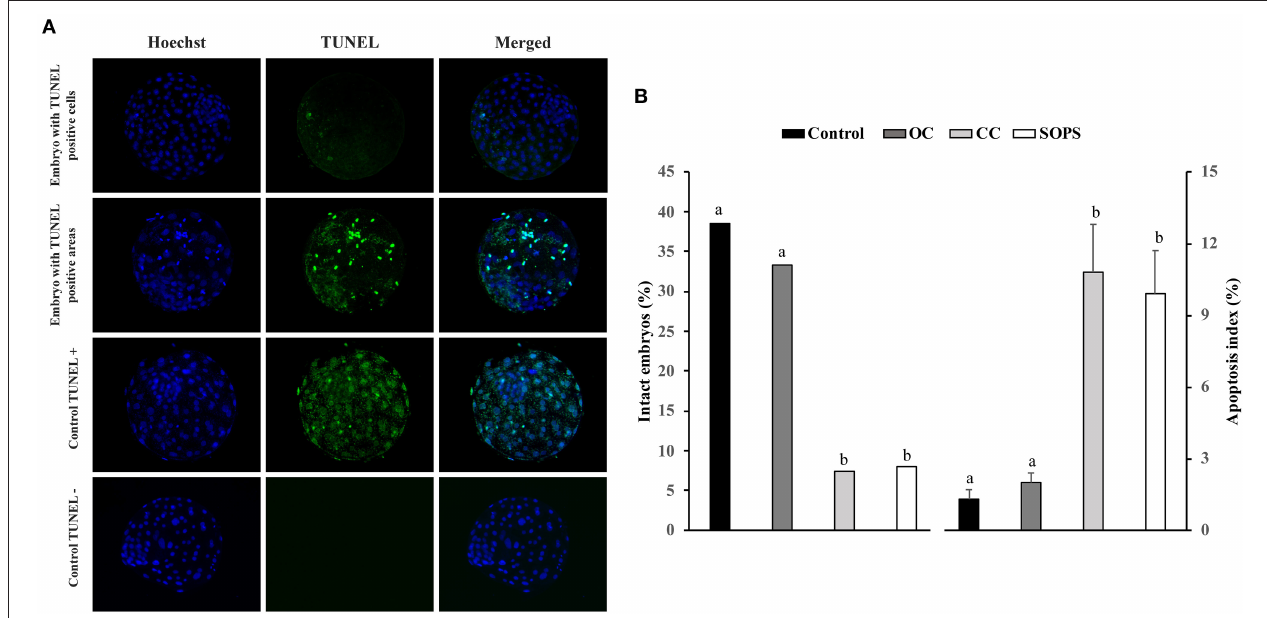
FIGURE 2 | Apoptosis in vitrified blastocysts. (A) Representative fluorescence images of the TUNEL assay of blastocysts stained with Hoechst-33342 (blue fluorescence) for total cells and TUNEL labeling (green fluorescence) for the detection of apoptosis. Positive and negative controls are included. (B) Apoptosis levels in blastocysts from control ( n = 26), open Cryotop ® (OC; n = 24), closed Cryotop ® (CC; n = 27) and SOPS ( n = 25) groups. a,b, p <